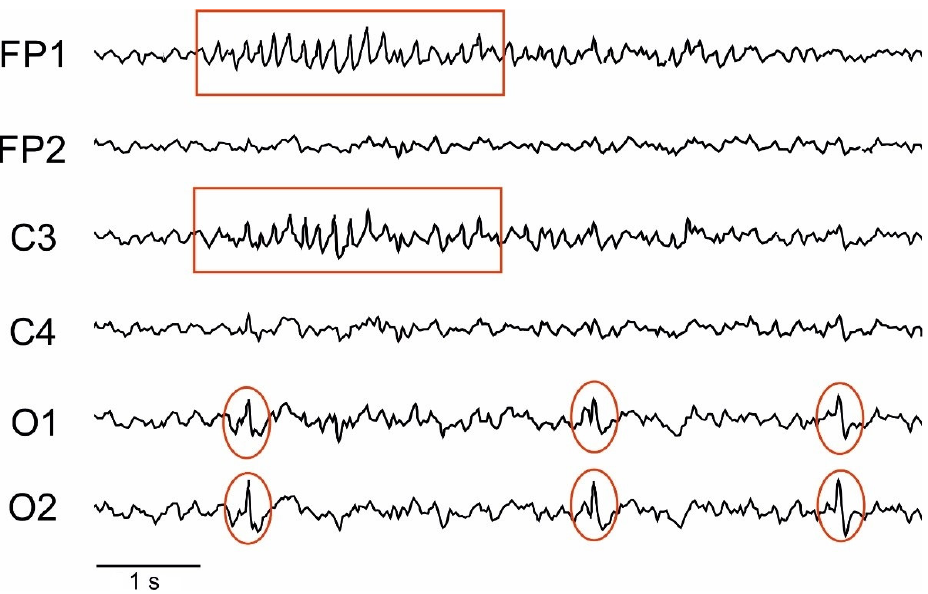
Figure 3. Epileptic activity (within red frames) observed in an IS 45 rat at post ‐ surgery day 7. Red ellipses mark the spikes in the O1/O2 area (above the hippocampus). In rats subjected to 30 ‐ min MCAO, an increase in θ rhythm indices in channels FP1 and C3 was observed at post ‐ surgery day 3 ( p < 0.05 vs. Control for both). A similar in ‐ crease was seen in all other channels, but did not reach statistical significance (Figure 4, Table S1). In the IS 45 group, a decrease in α , β‐ LF and β‐ HF rhythms ( p < 0.05 for channel FP2 in all cases) was accompanied by a slight increase in δ rhythm (not statistically signif ‐ icant) in the ischemic hemisphere (Figure 4, Table S1). At post ‐ surgery day 7, the changes were the same: a non ‐ specific decrease in δ rhythm indices (not statistically significant) and an increase in θ rhythm (IS 30: p < 0.01 for channel C4, p < 0.05 for channels FP1, FP2, and O2; IS 45: p < 0.01 for channel C4, p < 0.05 for channels FP2 and C3) (Figure 4, Table S2).